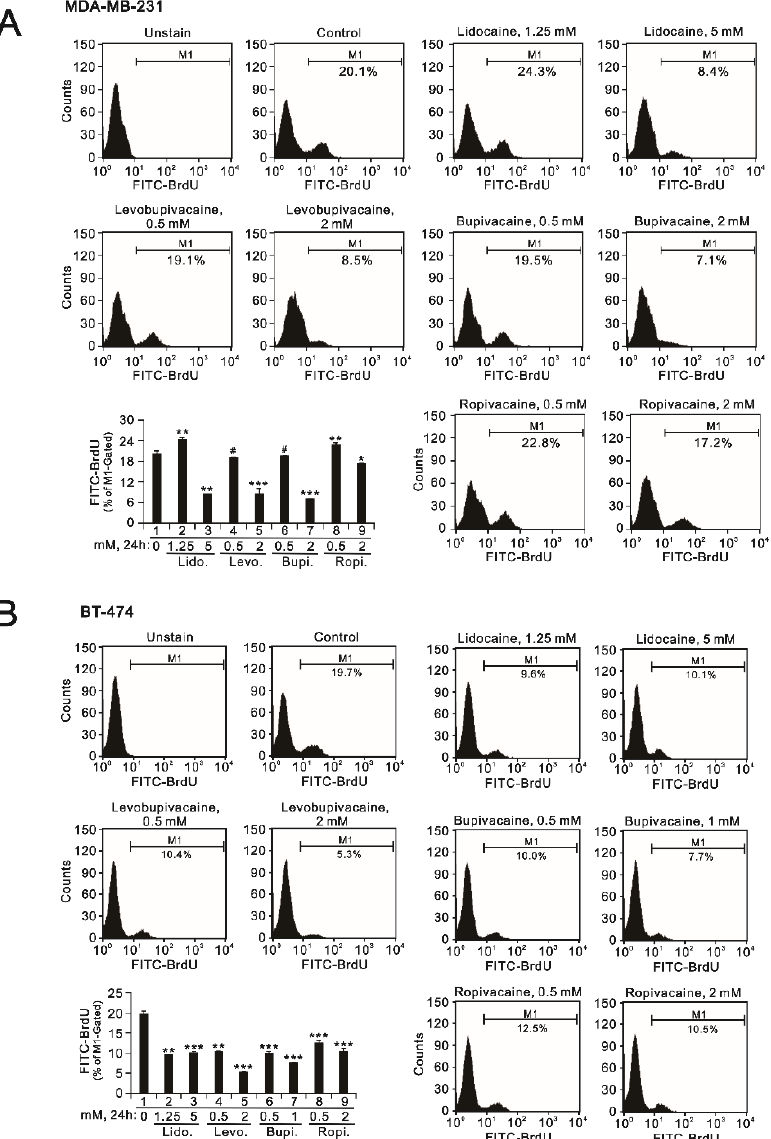
Figure 4. The effects of the local anesthetics on cell DNA synthetic activity in MDA-MB231 and BT-474 cells. ( A ) MDA-MB-231 and ( B ) BT-474 (3 × 10 5 ) cells were treated for 24 h with the indicated concentrations of the local anesthetics. After treatment, the cells were stained with BrdU, incorporated into newly synthesized DNA, progressed through the S phase (DNA synthesis), and then measured using flow cytometry analysis relative to the BrdU incorporation level. The results are representative of two independent experiments. Bars depict the mean ± SD. # p > 0.05; * p < 0.05; ** p < 0.01; *** p <0.001.